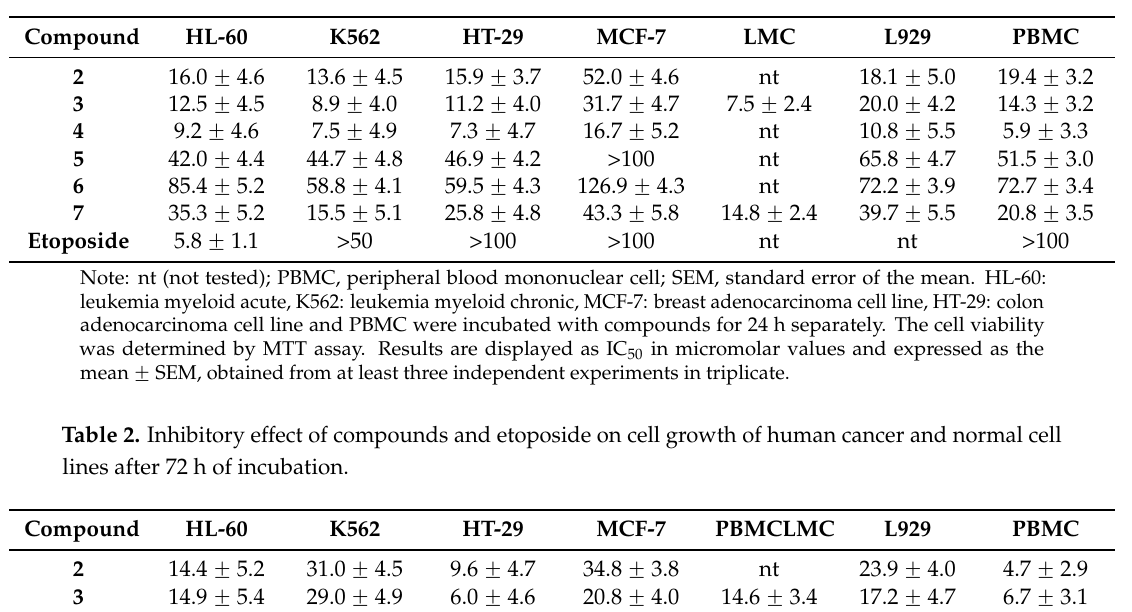
Table 1. Inhibitory effect of compounds and etoposide on cell growth of human cancer and normal cell lines after 24 h of incubation.